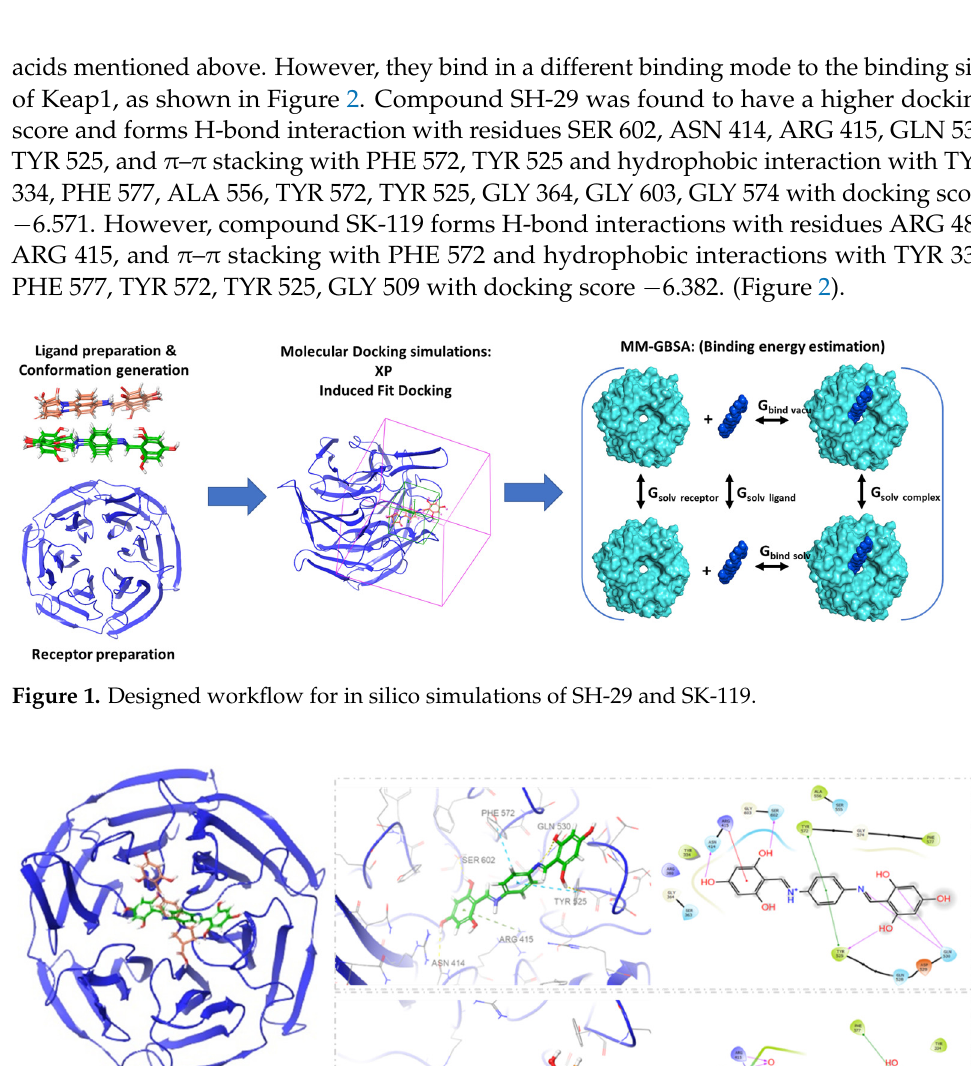
Figure 1. Designed workflow for in silico simulations of SH ‐ 29 and SK ‐ 119.